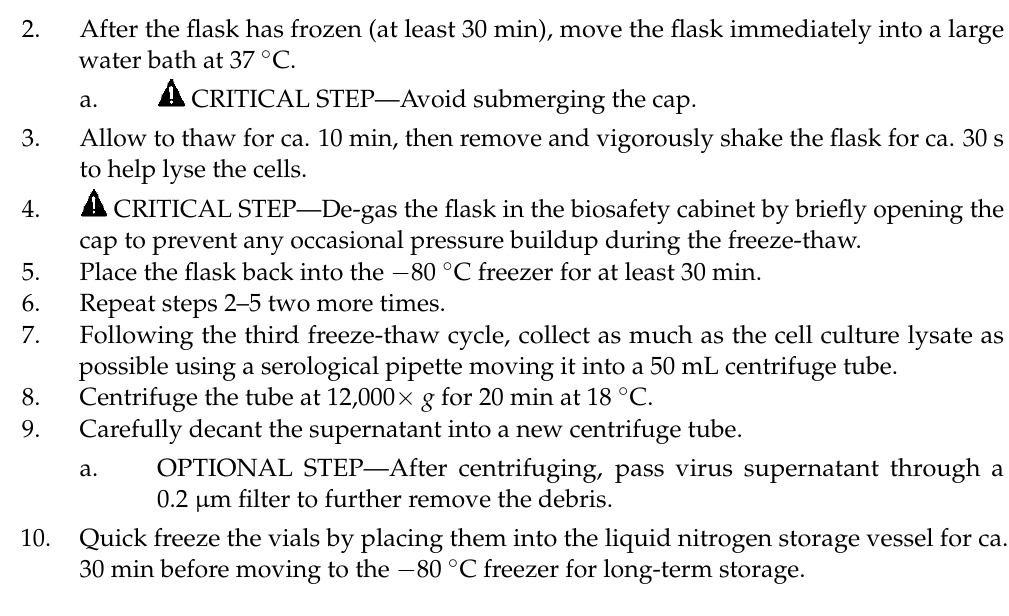
Figure 2. Cytopathic effect (CPE) of MHV infected NCTC clone 1469 cells after 19 h. Infected cells form syncytium: a multinucleated mass formed by the fusion of cells. Scale bar represents 1 mm.